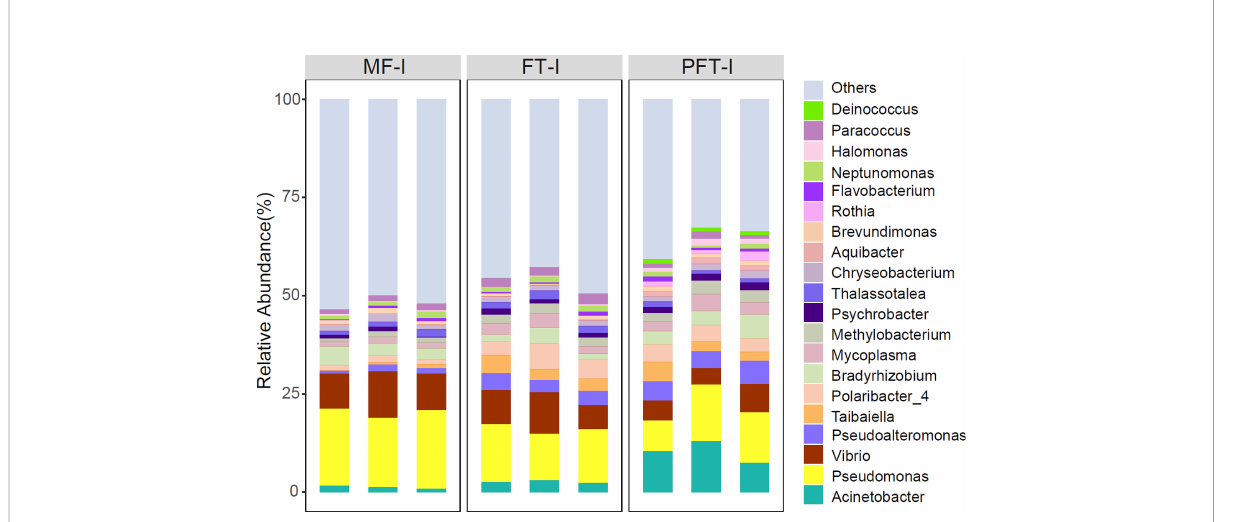
FIGURE 9 Relative abundances of major bacteria (top 20) in S. pharaonis intestine at the genus level. Microbial community bar plot at the genus level with the relative abundance higher than